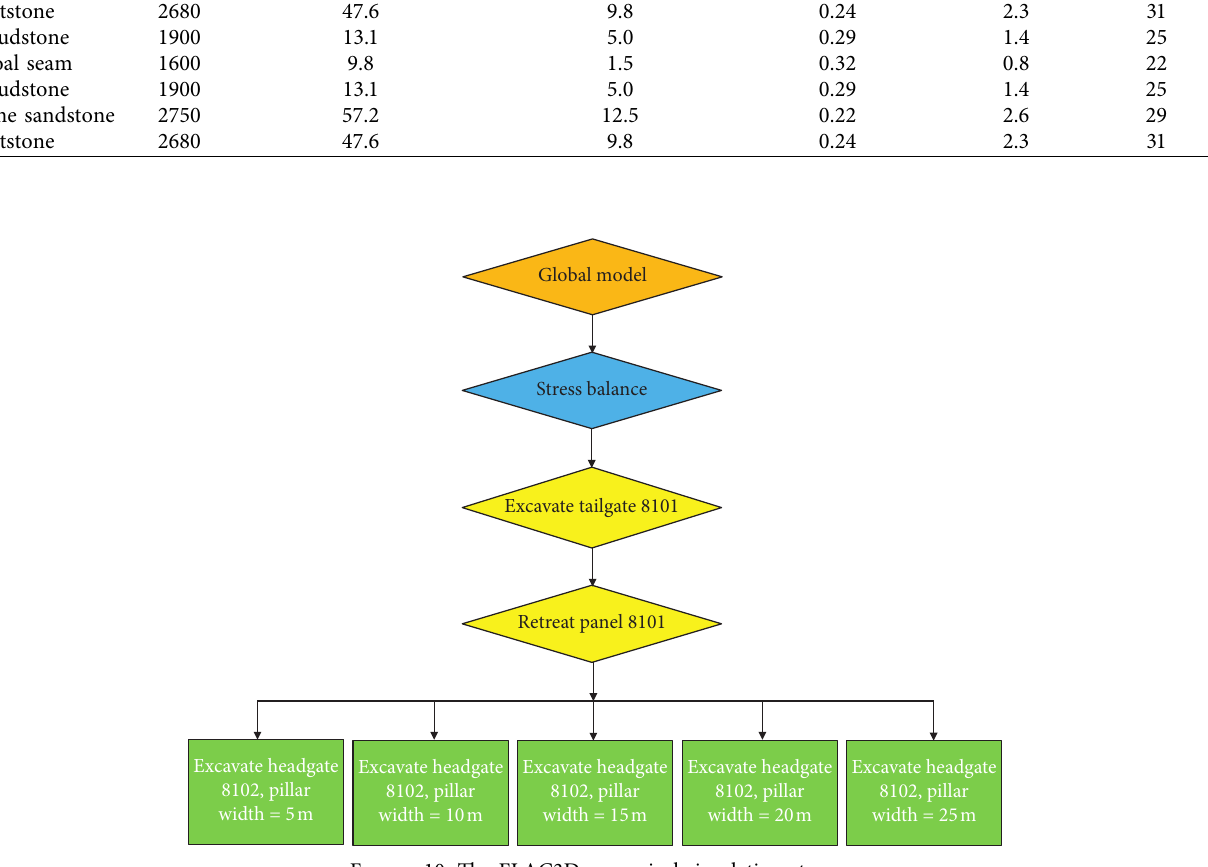
Figure 10: The FLAC3D numerical simulation steps. Table 2: Strain-softening properties of pillar with plastic